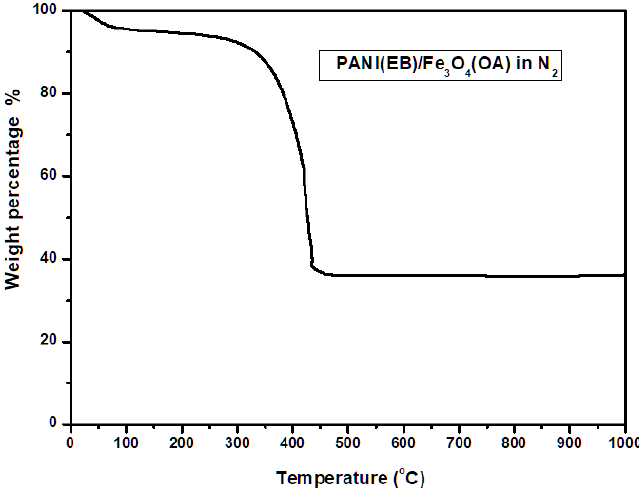
Figure 3. TGA thermogram of PANI(EB)/Fe 3 O 4 (OA)